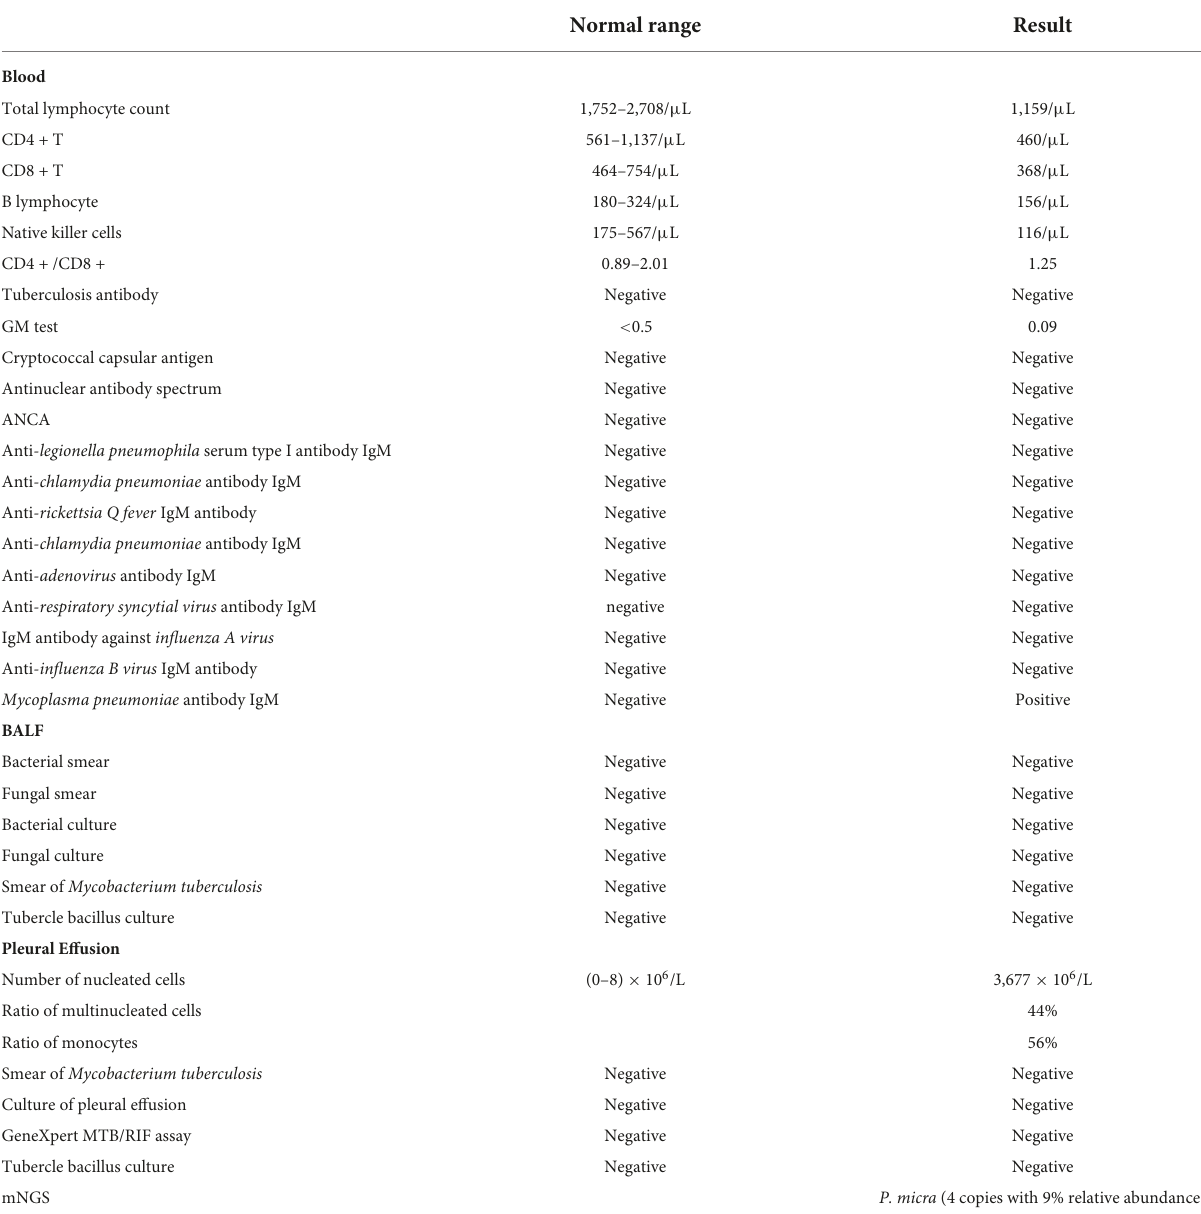
TABLE 1 Laboratory tests for clinical pathogen